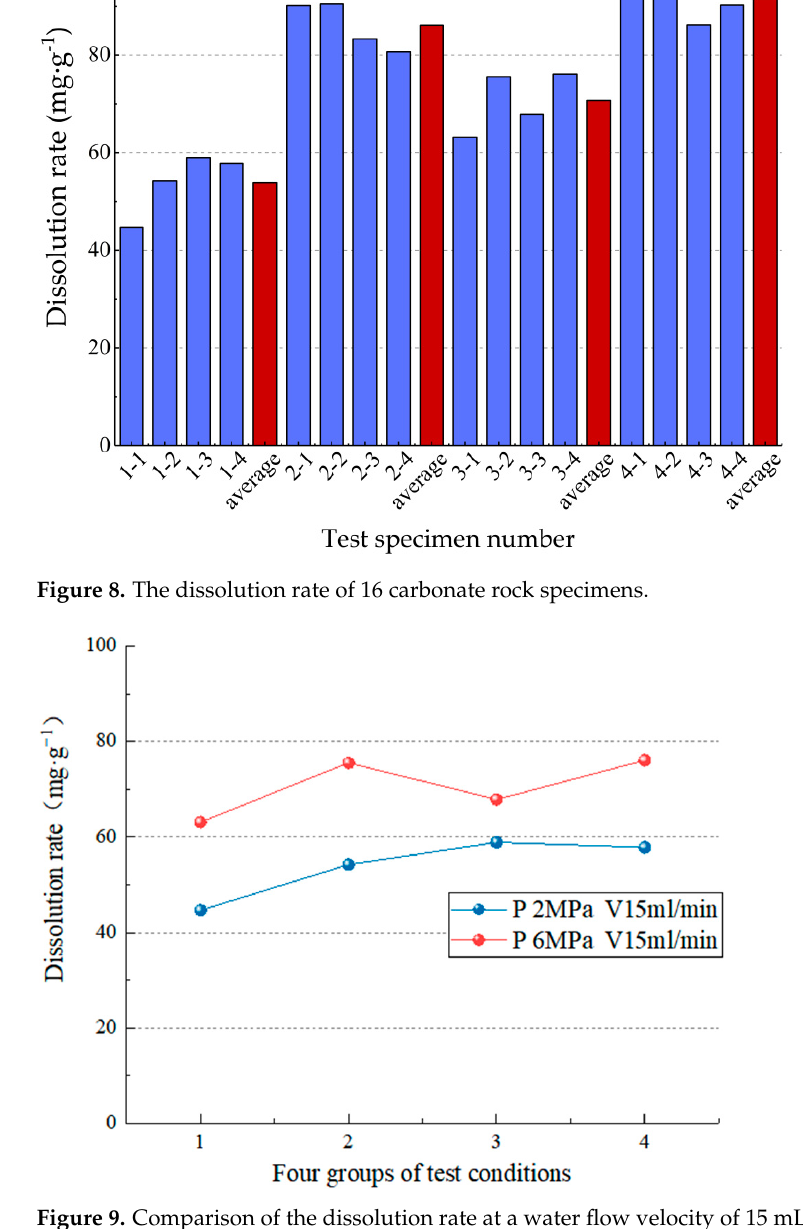
Figure 10. Comparison of the dissolution rate at a water flow velocity of 75 mL/min. 4.2.2. Dissolution Characteristics under Different Water Flow Velocities Two groups of experimental data with different flow rates were analyzed under the same hydrodynamic pressure. Figures 11 and 12 show that when the hydrodynamic pres- sure is 2 or 6 MPa, the dissolution rate at a 75-mL/min flow rate is more significant than that at a flow rate of 15 mL/min. This is because the movement of the aqueous solution accelerates the convection and diffusion of ions in the solution, as well as the dissolution rate of minerals, which causes the dissolution rate of minerals to increase with the increase in flow rate; that is, the higher the flow rate, the faster the dissolution rate of salt rock specimens. According to Liu et al.’s diffusion boundary layer theory [56], the higher the velocity, the thinner the diffusion boundary layer of carbonate rocks in the water, and the higher the erosion rate, making carbonate rock erosion more likely. On the other hand,